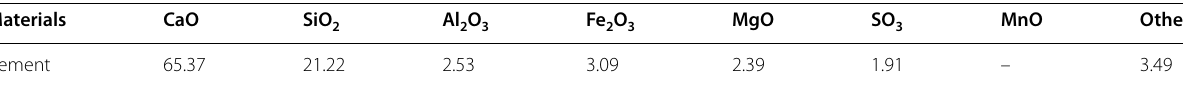
Table 1 Main chemical composition of cement (%).